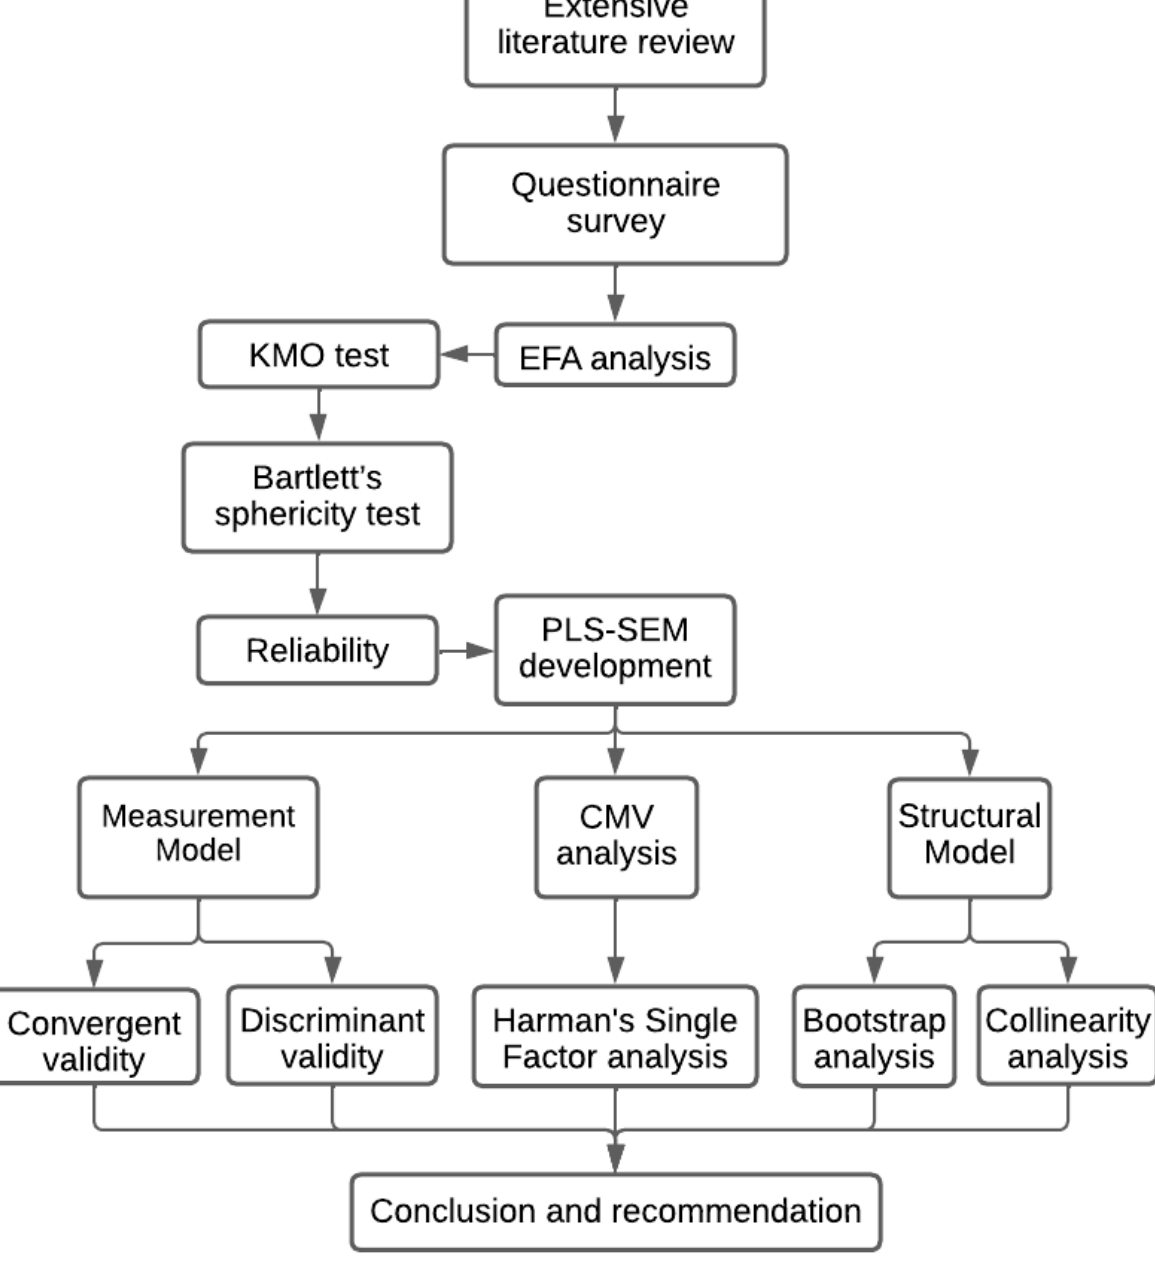
Figure 1. Research design.